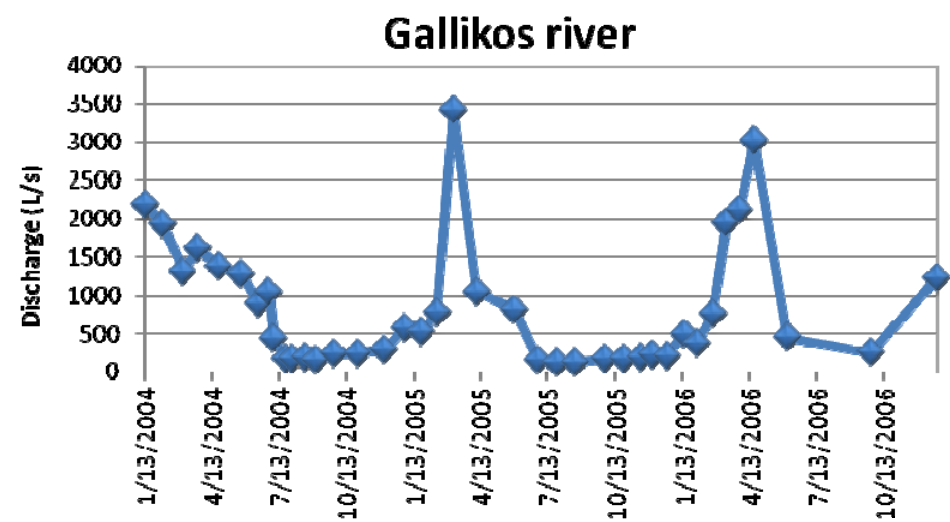
Figure 6. Mean monthly discharge of Gallikos River for period